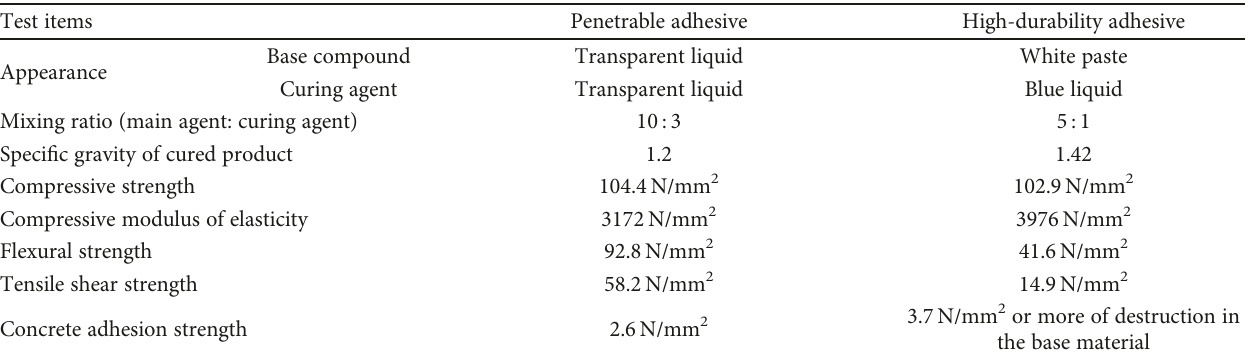
Table 5: Material characteristic value of adhesive.